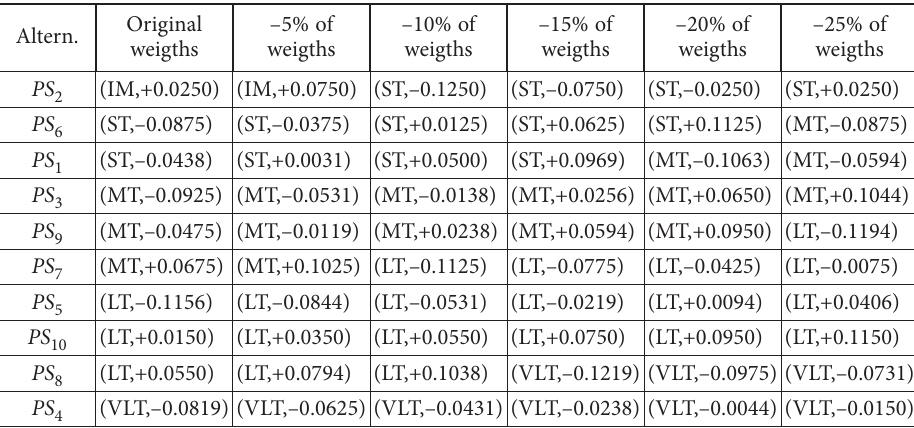
Table 6. Linguistic 2-tuples obtained for all the alternatives according to the variation introduced in the weights